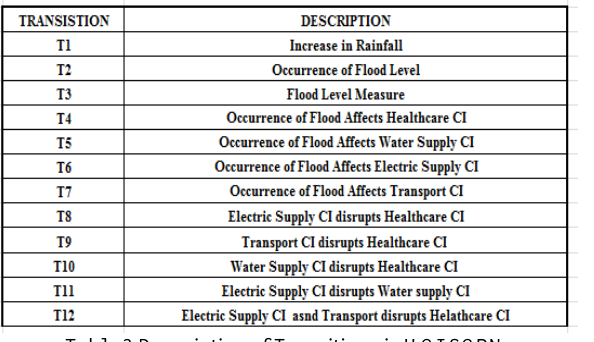
Table 3.Description of Transitions in HCI SCPN.